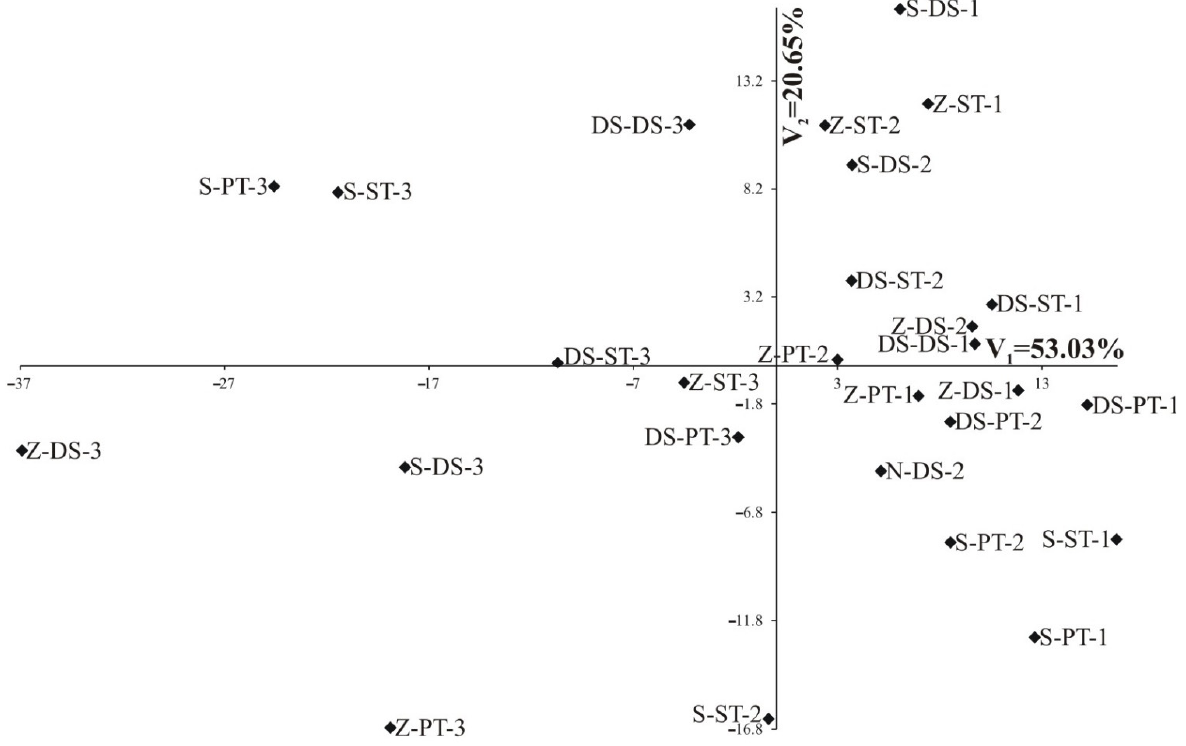
Figure 6. Distribution of spring wheat treatments in the two first canonical variates at the 5th term (cover crop: Z—zero, S—skimming, DS—direct sowing, ST—simplified tillage, PT—spring ploughing; years: 1—2011, 2—2012, 3—2013).